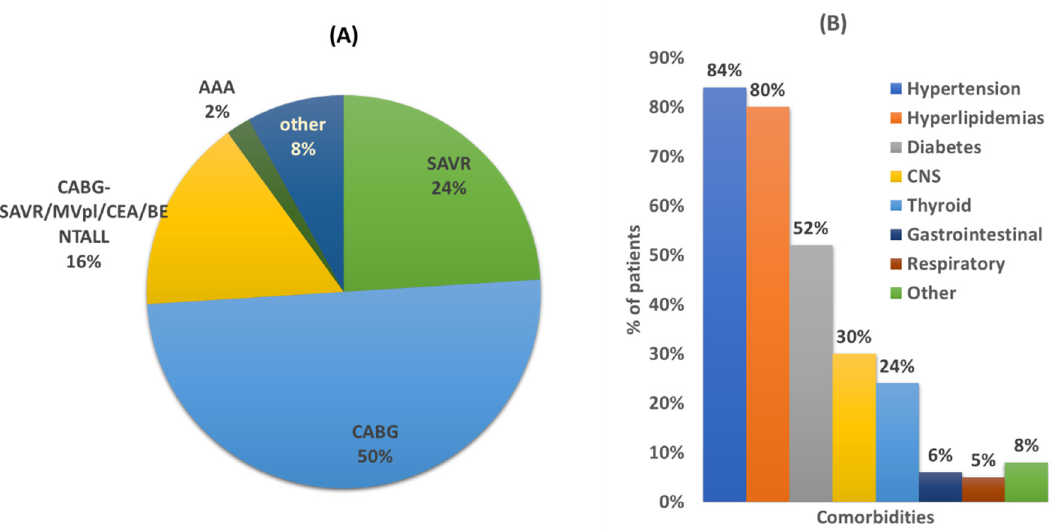
Figure 1. ( A ) Diagnosis for CTS surgery. Coronary artery bypass graft (CABG) surgery; surgical aortic valve replacement (SAVR); mitral valve prolapse (MVPl); carotid endarterectomy (CEA); abdominal aortic aneurysm (AAA); Bentall: aortic root replacement surgical procedure. ( B ) Comorbidities of studied population. CNS: central nervous system. Other comorbidities refer to rheumatoid arthritis, cancer, prostatic hyperplasia, sleep apnea, hepatitis C, chronic kidney failure, and scleroderma.